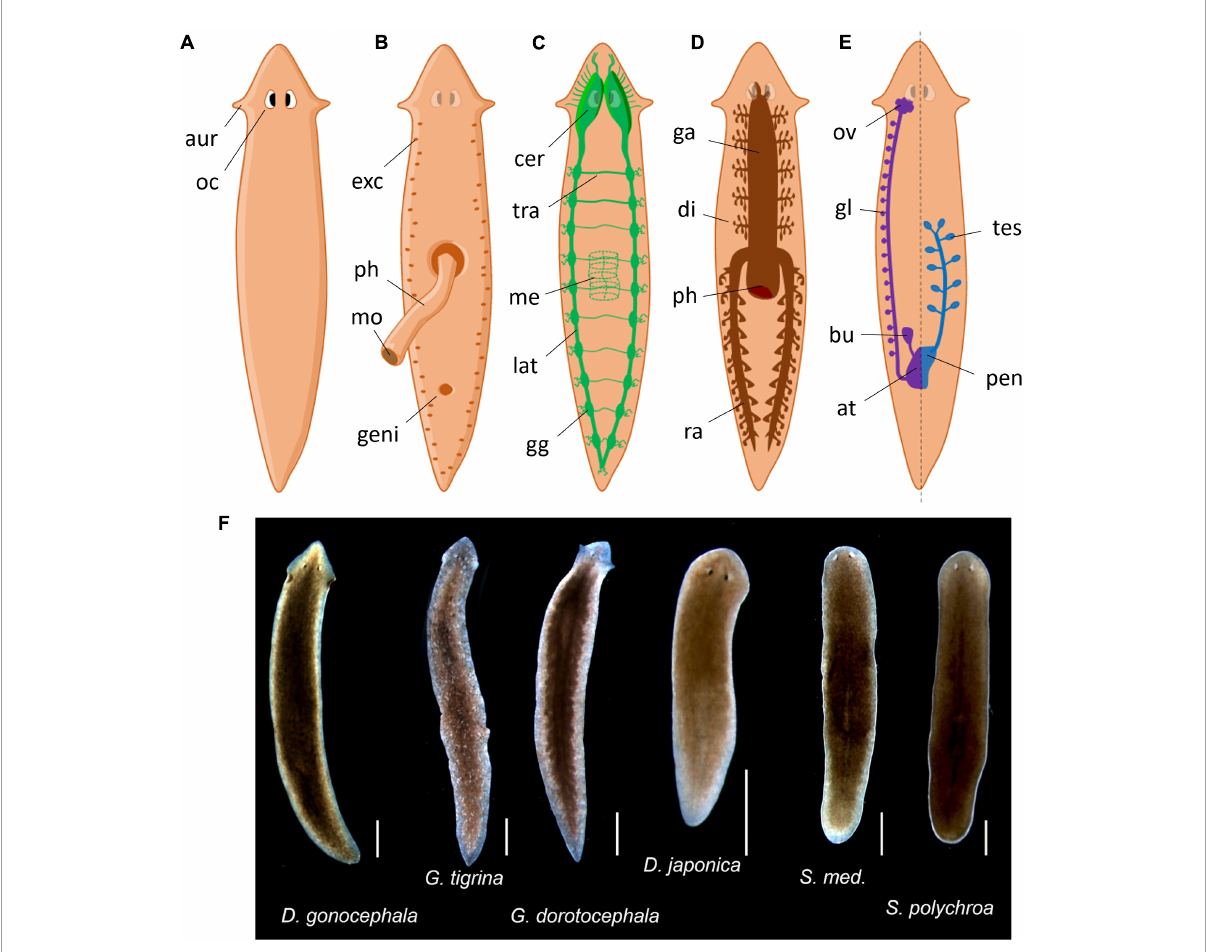
FIGURE1 Common planarian representations. (A) Dorsal exterior view. aur, auricles; oc, ocelli. (B) Ventral exterior view with extruded pharynx. exc, excretory pores; ph, pharynx; mo, mouth; geni, genital pore. (C) Nervous system. cer, cerebral ganglions; tra, transversal nerve; me, pharyngal mesh of neurons; lat, lateral nerve cord; gg, lateral ganglions. (D) Gastrovascular system. ga, gastrovascular cavity; di, diverticulum; ph, pharynx; ra, posterior ramus. (E) Reproductive system, female is represented on the left and male on the right but both are present symmetrically. ov, ovary; gl, yolk glands; bu, bursa copulatrix; at, genital atrium; tes, testis; pen, penis. (F) Photos of common planaria species from our laboratory (scale: 1